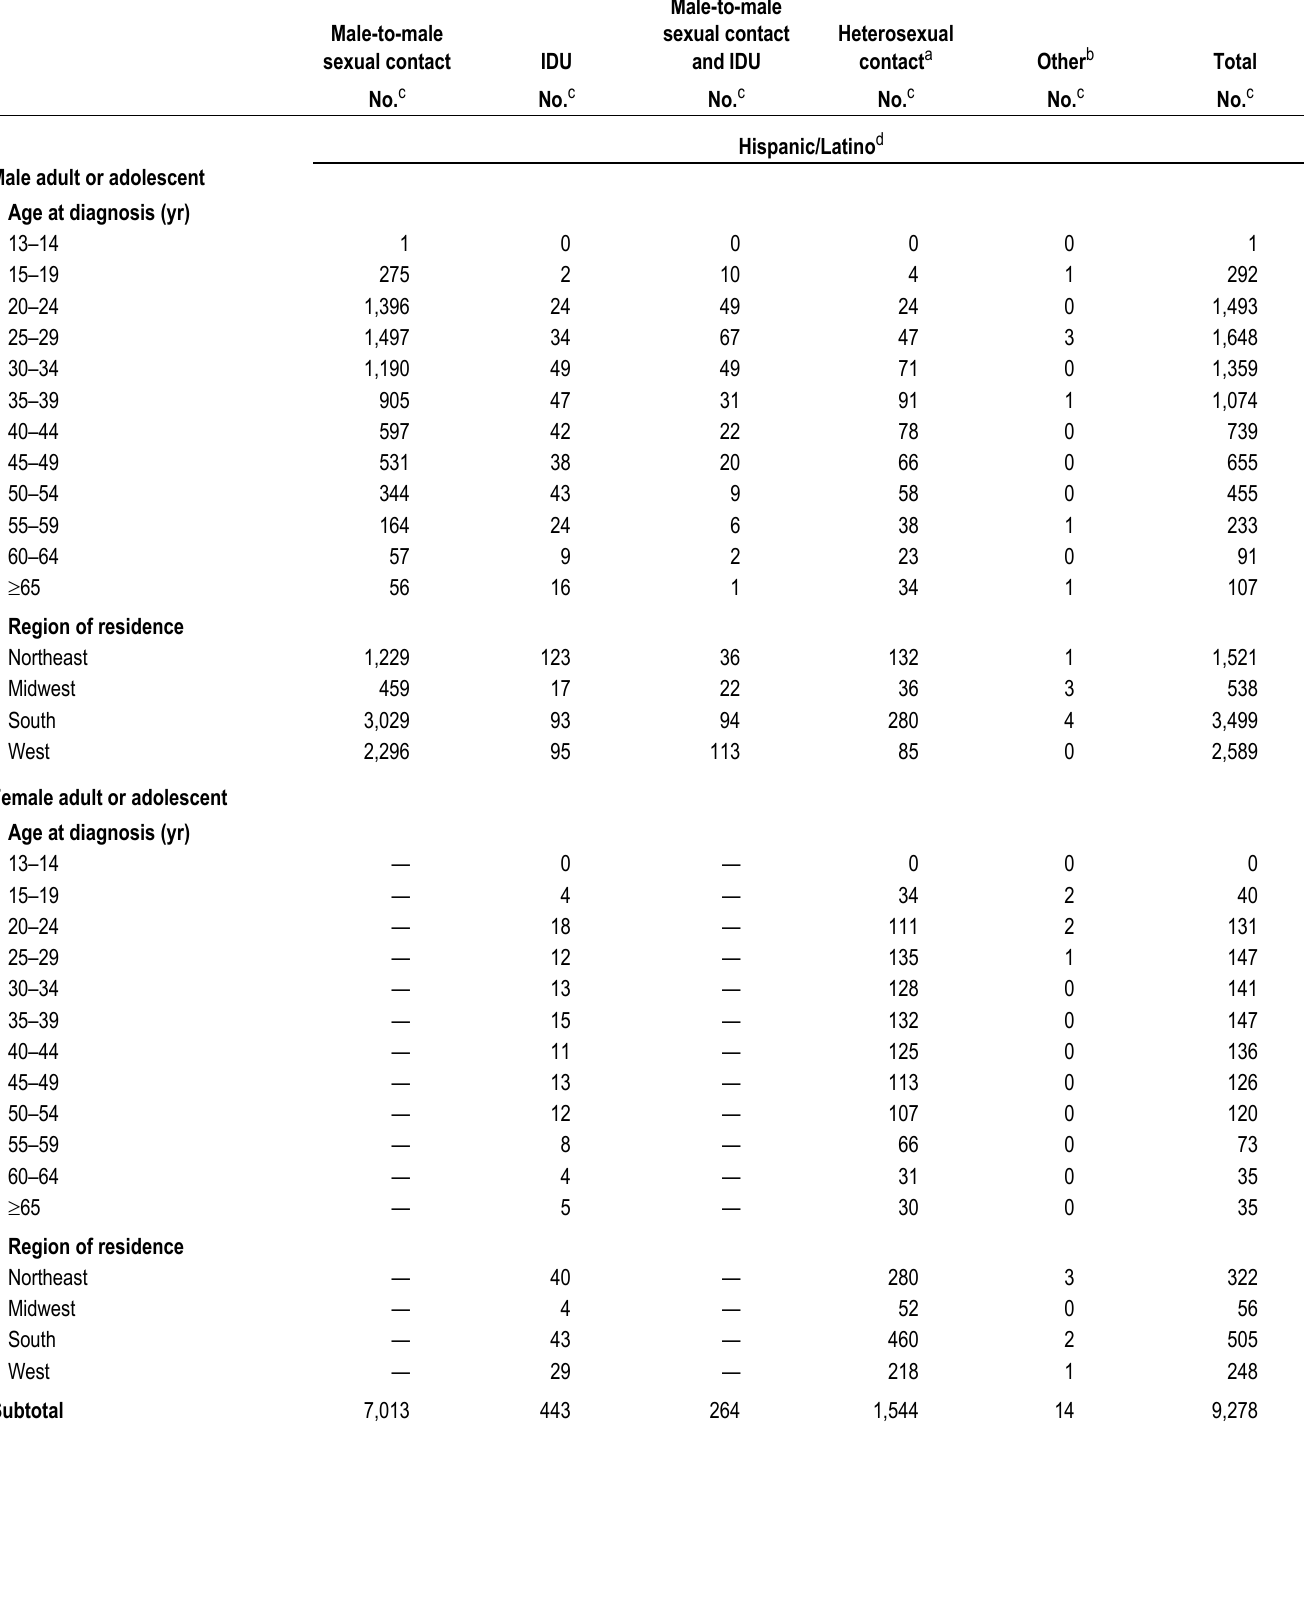
Table 5a. Diagnoses of HIV infection, by transmission category, race/ethnicity, and selected characteristics, 2015—United States